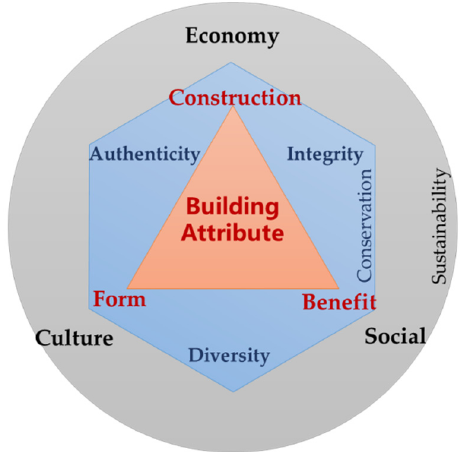
Figure 2. The three dimensions of building attributes based on